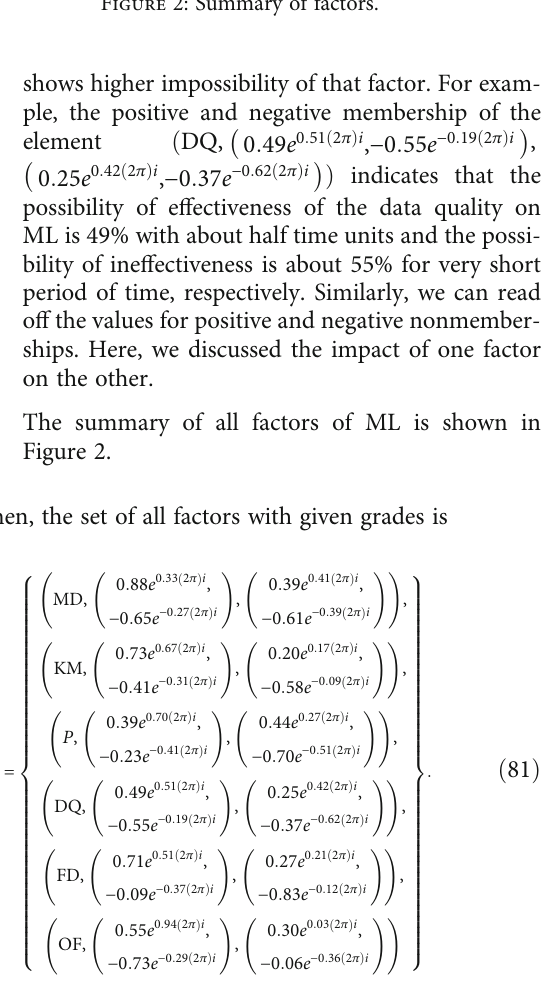
Þ indicates that the